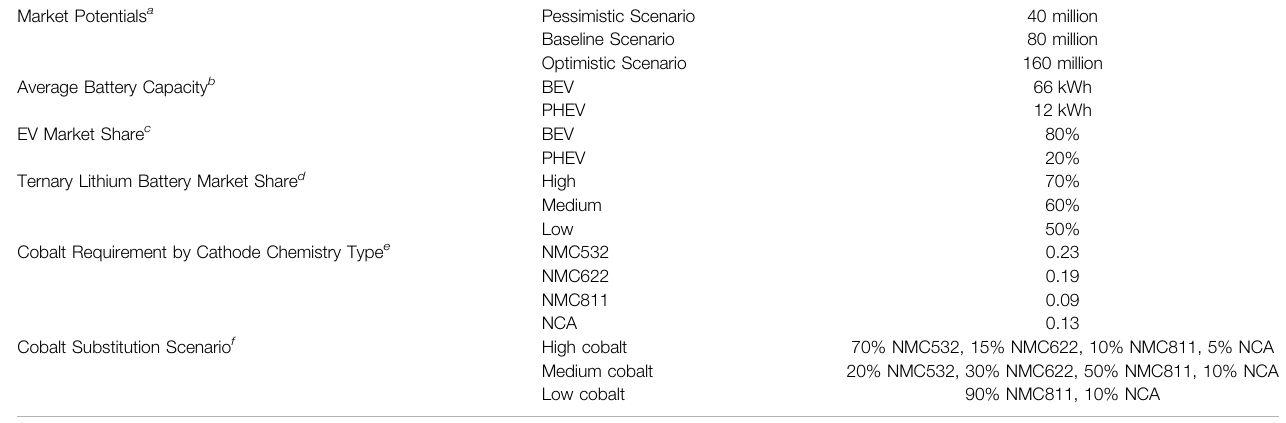
TABLE 2 | Assumptions on major